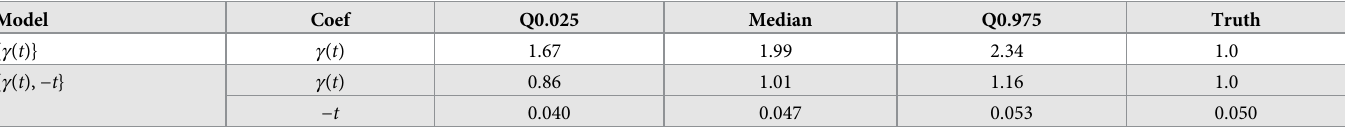
Table 1. Summary of simulated fixed-tree data inference. Posterior distribution quantile summaries for BNPR-PS with no covariates (model: { γ ( t )}, first row) and BNPR-PS with an ordinary covariate (model: { γ ( t ), − t }, second and third rows).